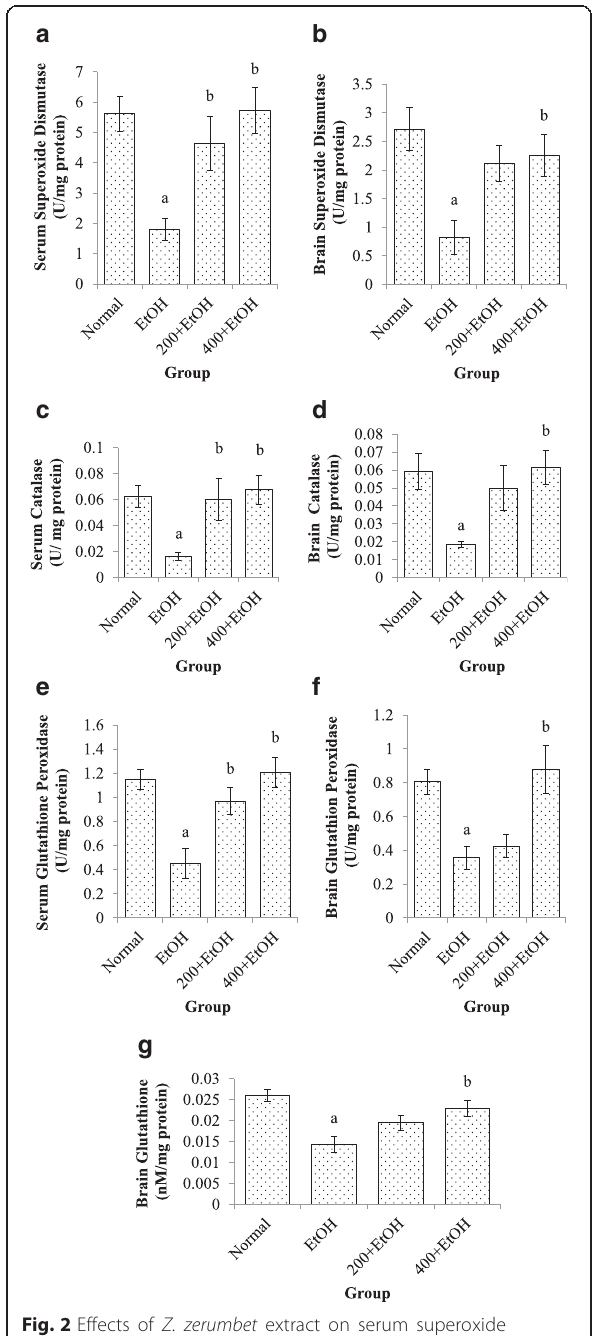
Fig. 2 Effects of Z. zerumbet extract on serum superoxide dismutase ( a ), brain superoxide dismutase ( b ), serum catalase ( c ), brain catalase ( d ), serum glutathione peroxidase ( e ), brain glutathione peroxidase ( f ) activities and brain glutathione level ( g ). Values are expressed as mean ± SEM. “ a ” significant at F(5,18) = 16.978, p < 0.5 compared to normal group; “ b ” significant at p < 0.05 compared to ethanol group. ( N = 6). (EtOH: ethanol; 200 + EtOH: 200 mg/kg extract + ethanol; 400 + EtOH: 400 mg/kg extract +